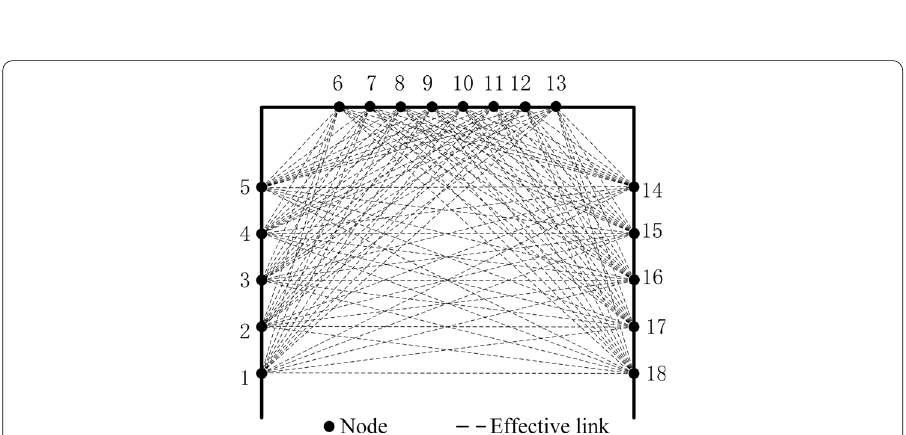
Fig. 3 Schematic diagram of node deployment and effective wireless link